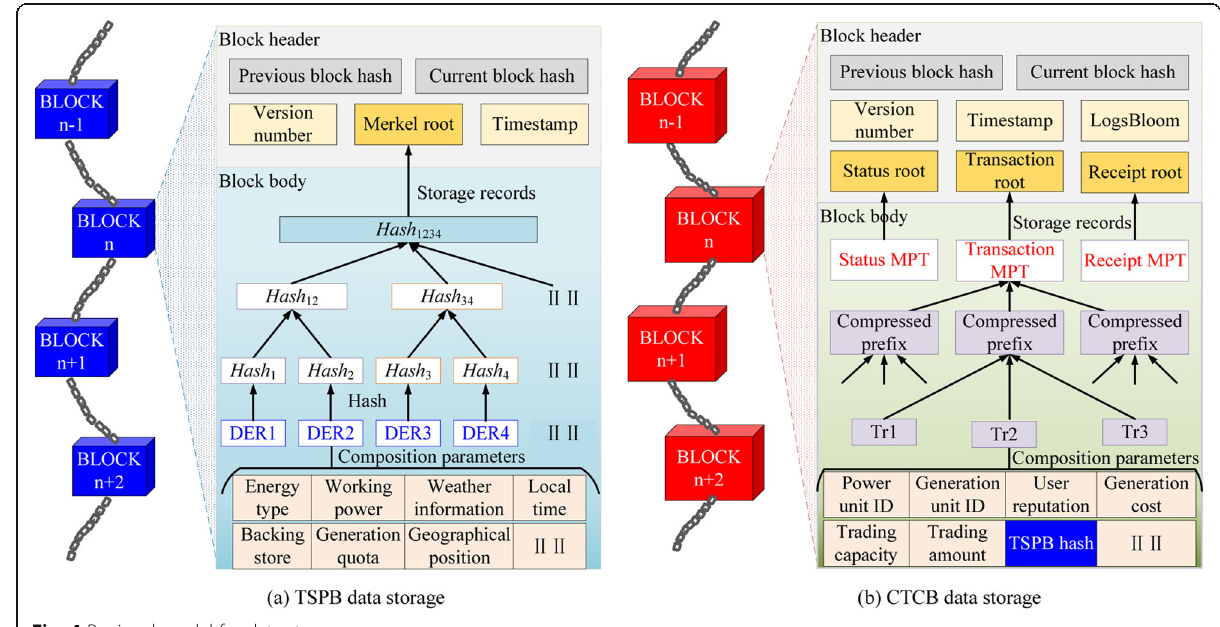
Fig. 4 Regional model for data